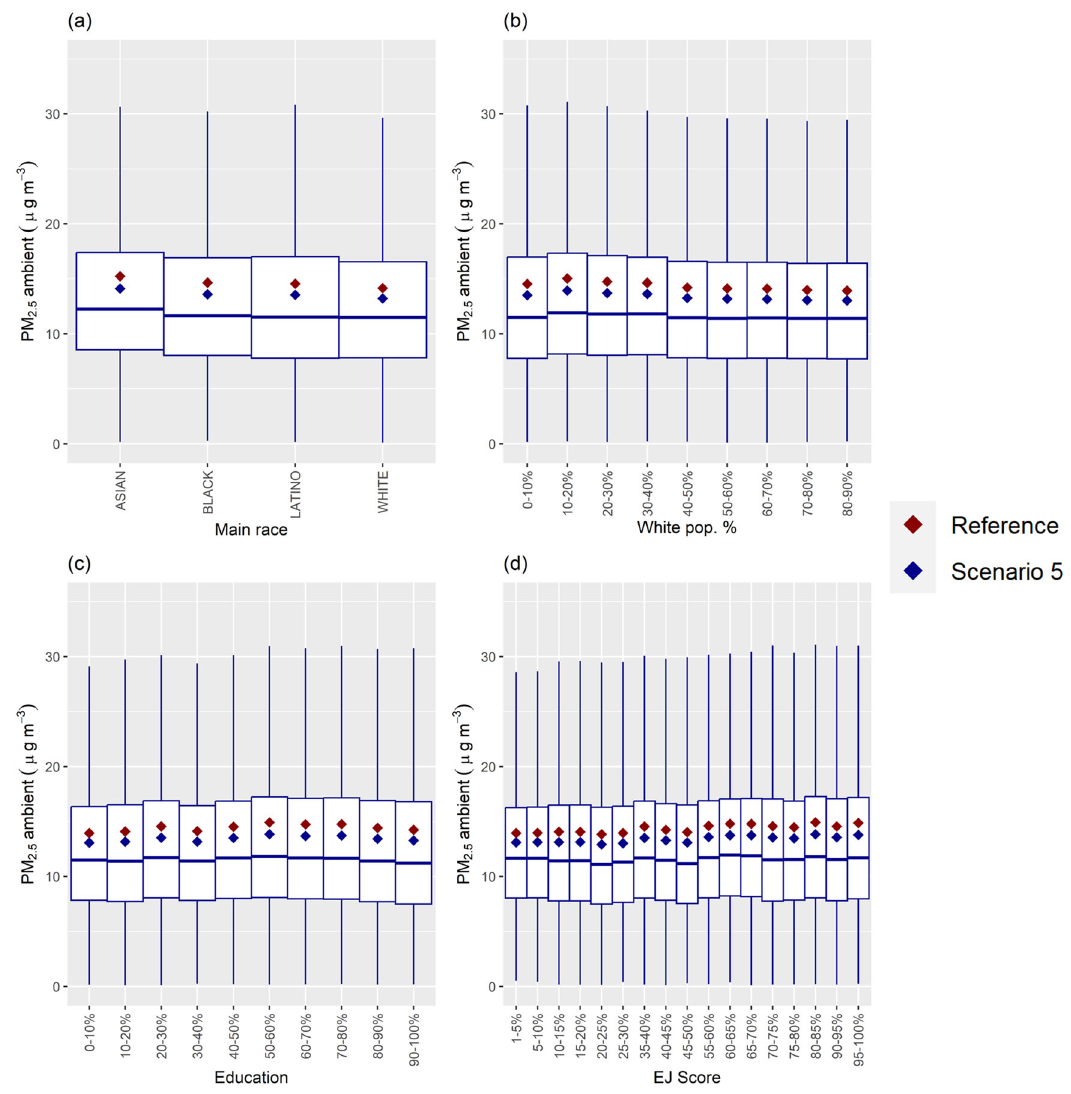
Fig. 7 PM 2.5 concentrations grouped by CalEnviroScreen EJ parameters for Scenario 5. The EJ parameters include ( a ) race, ( b ) white population percentage, ( c ) percent of population with a degree lower than high school, and ( d ) the fi nal score in CalEnviroScreen. Blue diamonds represent mean concentrations. Boxes are bound by the scenario ’ s 25% and 75% range. Reference Case means shown as red diamonds for comparison. The whiskers extend to 1.5 times of the IQR from the